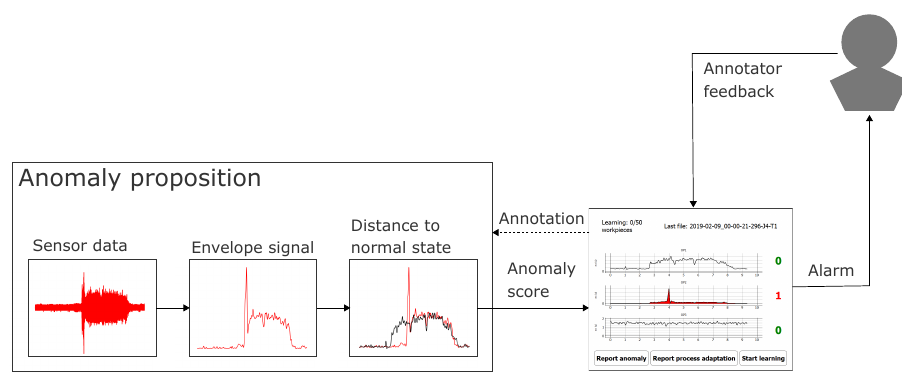
Figure 6. Visual summary of the live annotation approach: From raw sensor signals, we extract envelope signals. The envelope signals under review (red) are compared to the normal data (black) or a representation of it (distance to normal centroid for NC model, crossing of amplitude threshold for threshold heuristics). When the anomaly score assigned by the anomaly proposing model exceeds a threshold, an alarm signal is generated via the labeling prototype, which triggers human feedback by the machine operator. The assigned labels can optionally be fed back to the anomaly proposing model in order to learn a semi-supervised model (part of future